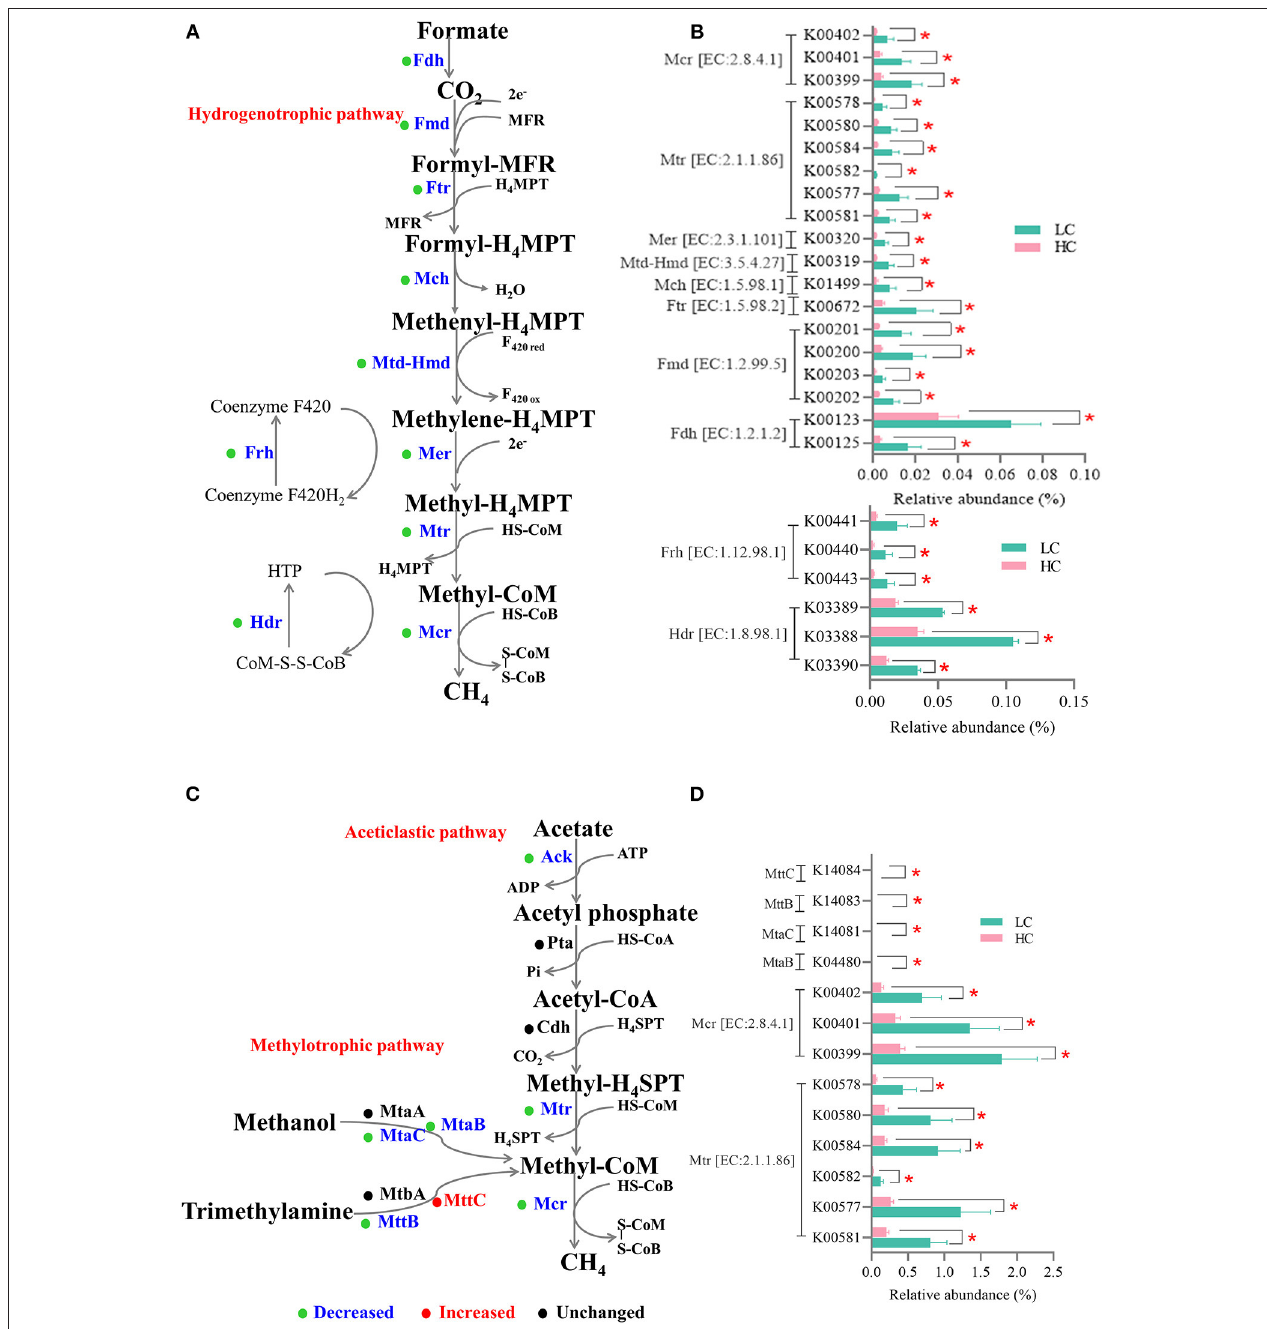
FIGURE 5 | Effects of high-concentrate (HC) feeding on microbial genes involved in methanogenesis of dairy cows. The enzymes involved in the methanogenesis pathway—the hydrogenotrophic route (A) and the acetoclastic route, and the methylotrophic route (C) . The relative abundance of microbial genes involved in the hydrogenotrophic route (B) and the acetoclastic and methylotrophic route (D) . The blue font indicated that the relative abundance of this enzyme was significantly reduced in the HC group. * p < 0.05.